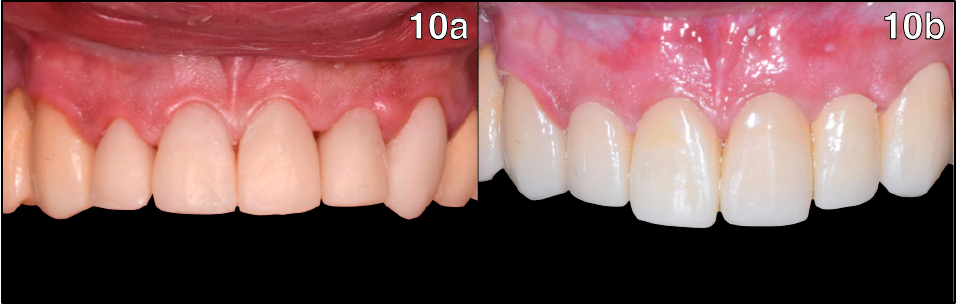
Figure 10. Plastic try-in and delivery: ( 10a ) ideal contouring of the gingival architecture and healthy periodontal tissues can be observed; ( 10b ) final delivery of the full-coverage monolithic zirconia restorations.